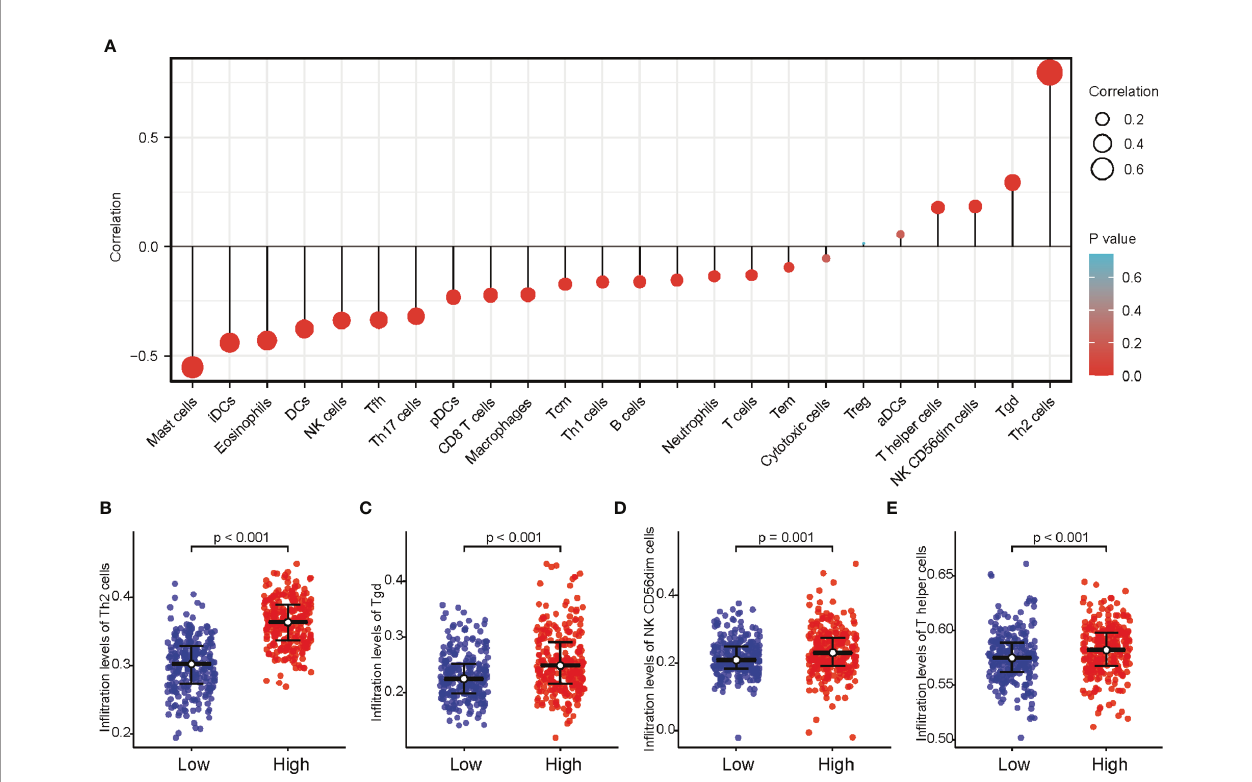
FIGURE 6 | Association between the expression level of NUF2 and immune in fi ltration in the tumor microenvironment. (A) The forest plot shows the correlation between NUF2 expression level and 24 immune cells. (B) the enrichment scores of NUF2 expression in Th2 cells and macrophages; (C) Enrichment scores of NUF2 expression in Tgd cells; (D) Enrichment scores of NUF2 expression in NK CD56dim cells. (E) Enrichment scores of NUF2 expression in T helper